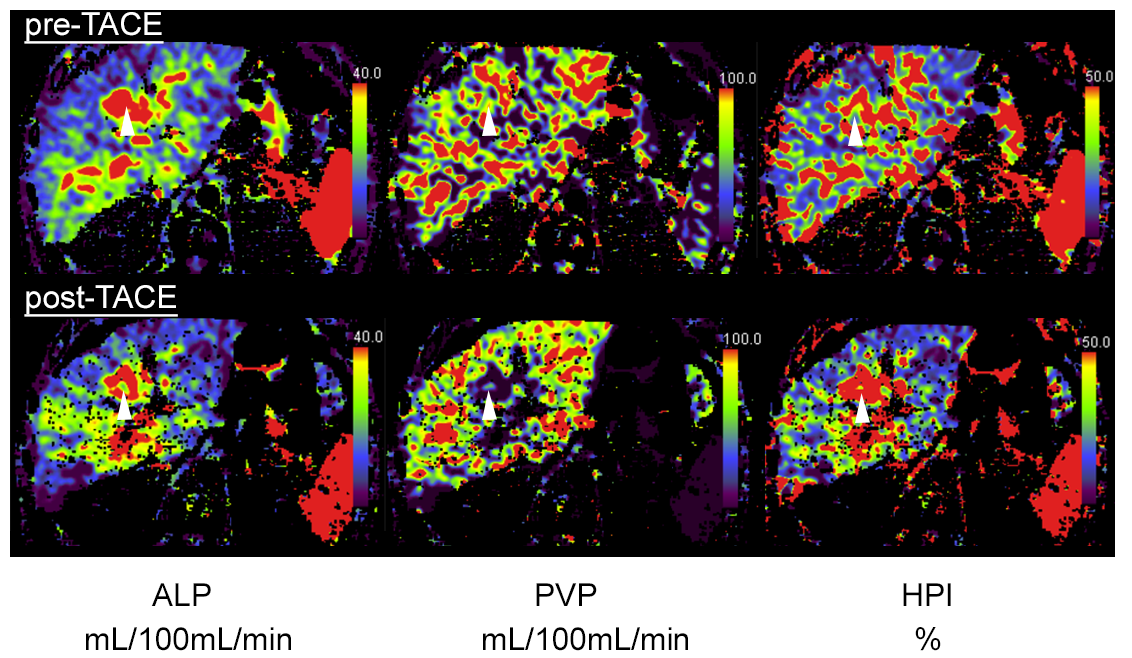
Figure 2. A 64-year-old patient with central HCC and incomplete embolization after transarterial chemoembolization (TACE). Pre-TACE images (top row) show increased arterial-liver perfusion (ALP, left, white arrowhead), slightly reduced portal-venous perfusion (PVP, middle ) and increased hepatic-perfusion index (HPI, right ) compared to normal liver tissue. Post-TACE images (bottom row) reveal a slight decrease in ALP ( left ), indicative of residual-tumor tissue.